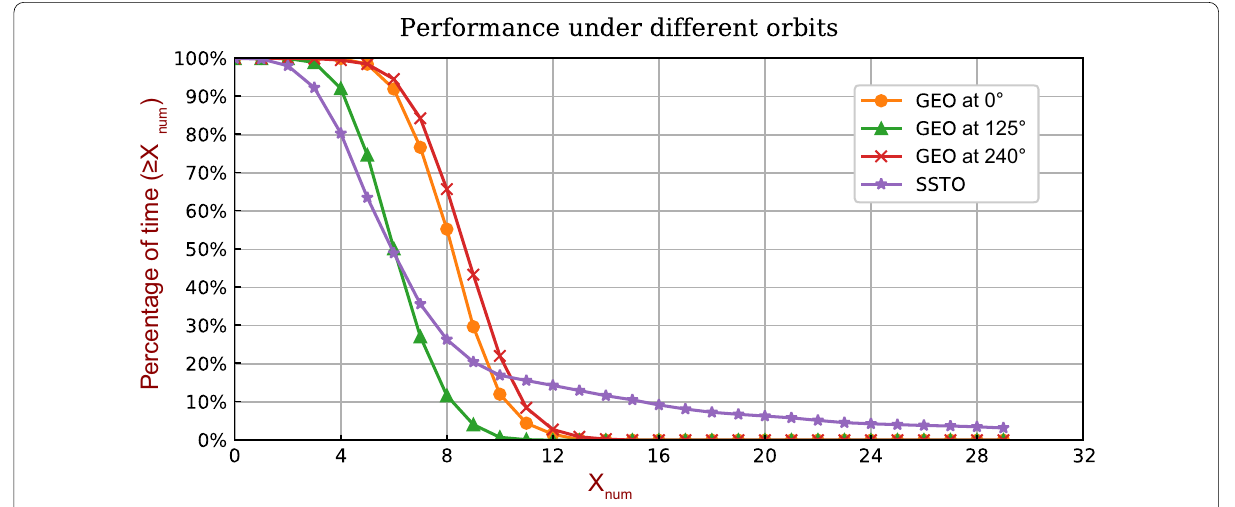
Fig. 8 Percentage of time with the number of visible satellites